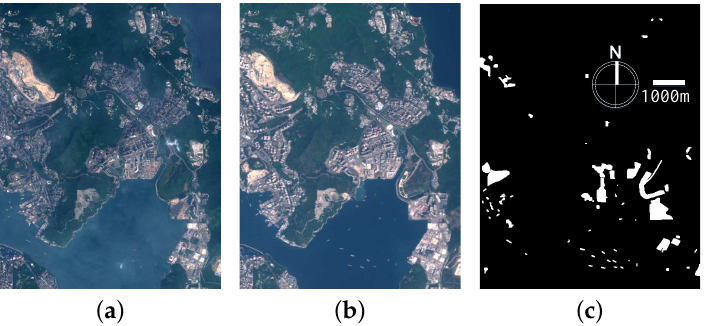
Figure A5. The Hongkong dataset: ( a ) the multispectral image acquired in September 2016, ( b ) the multispectral image acquired in March 2018, and ( c ) the reference